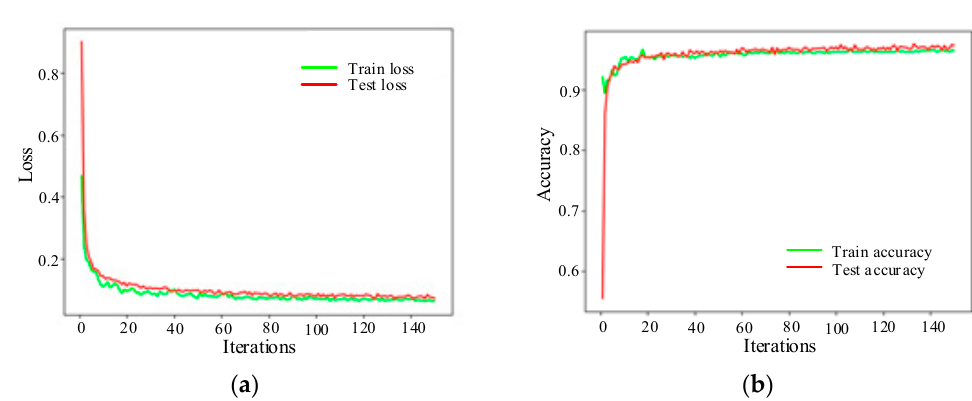
Figure 19. Leakage level identification. (a) Identification loss; (b) Identification accuracy